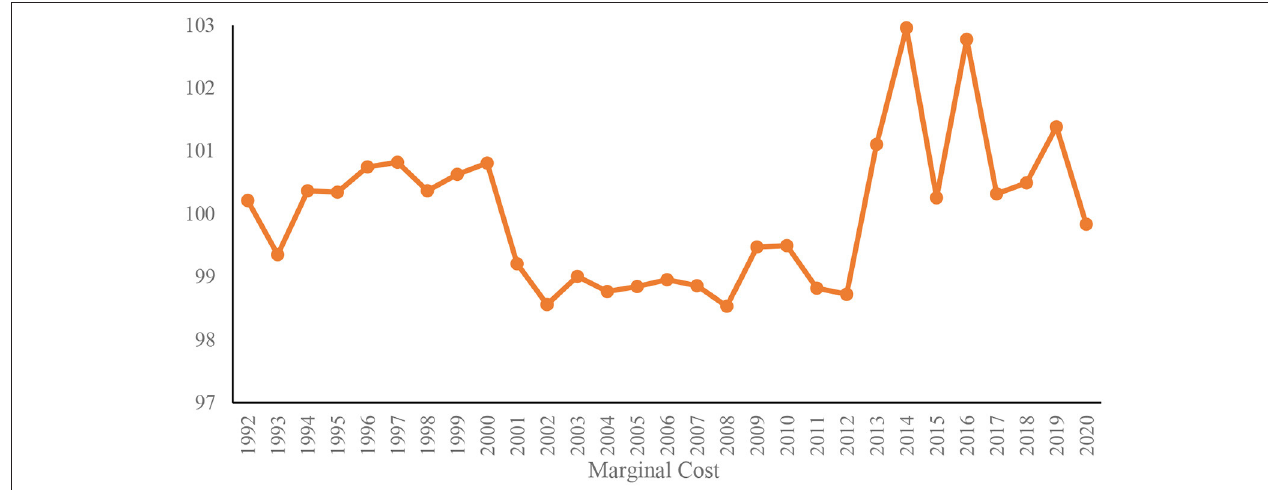
FIGURE 2 | Trend of the marginal cost of medical products in China (HS: